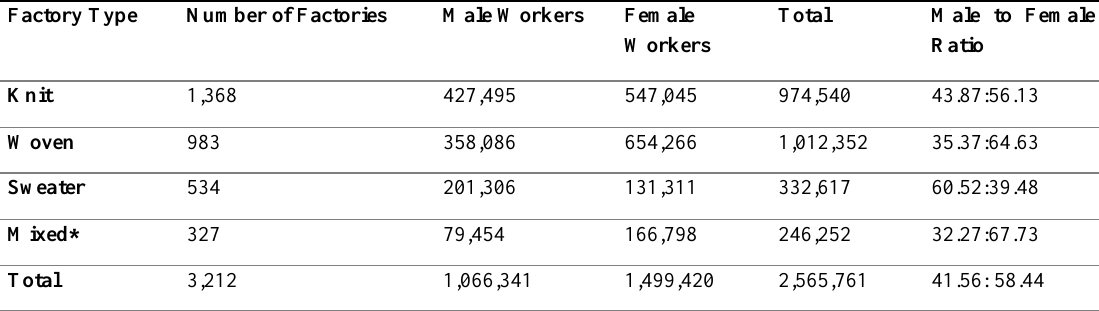
Table 2: Garments Factories and Garments Workers’ Ratio in terms of Factory Type Factory